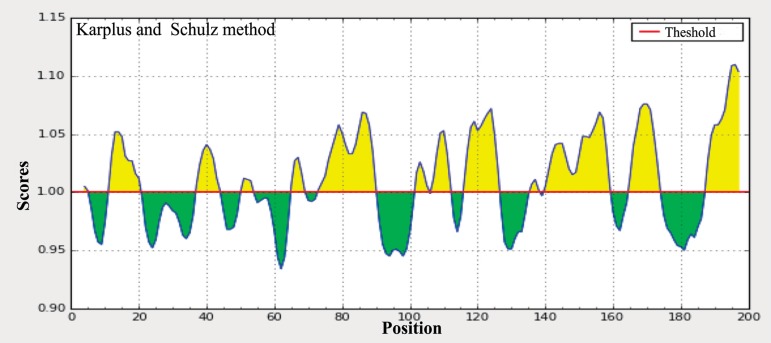
Karplus and Schulz flexibility prediction of Arabian camel HSPB-1 protein.The x-axis and y-axis represent the position and score, respectively. The threshold is 1.0. The flexible regions of the protein are shown in yellow color, above the threshold value.